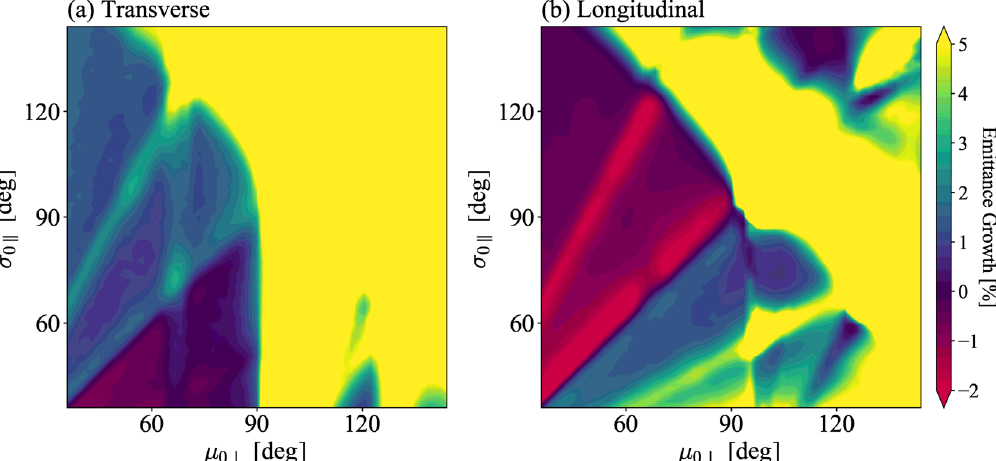
.FIG. 7. W ARP simulation result obtained with a nonequipartitioned Gaussian distribution. The transverse and longitudinal emittance growth rates at the exit of the 100th AG cell are plotted separately in the left panel (a) and the right panel (b). The beam intensity is fixed at the value that gives η ⊥ ¼ 0 . 7 at the operating point ð μ 0 ⊥ ; σ 0 k Þ ¼ ð 57 . 6 ° ; 57 . 6 ° Þ